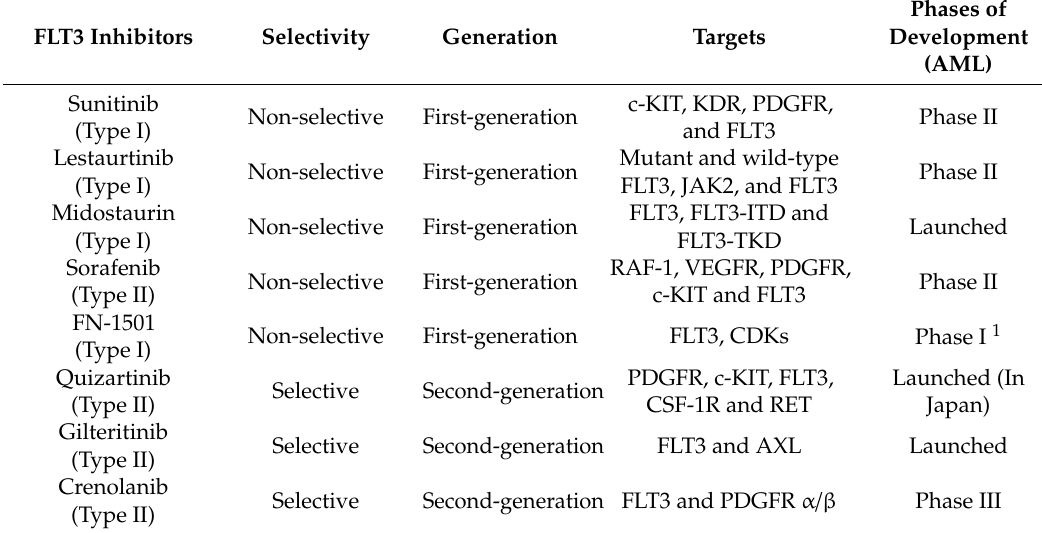
Table 1. FLT3 tyrosine kinase inhibitors under clinical